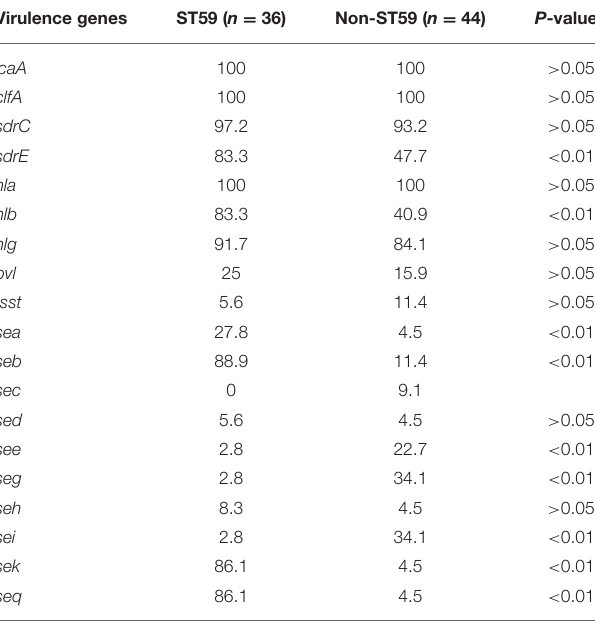
TABLE 5 | Frequencies of virulence genes among ST59 and non-ST59 isolates. Virulence